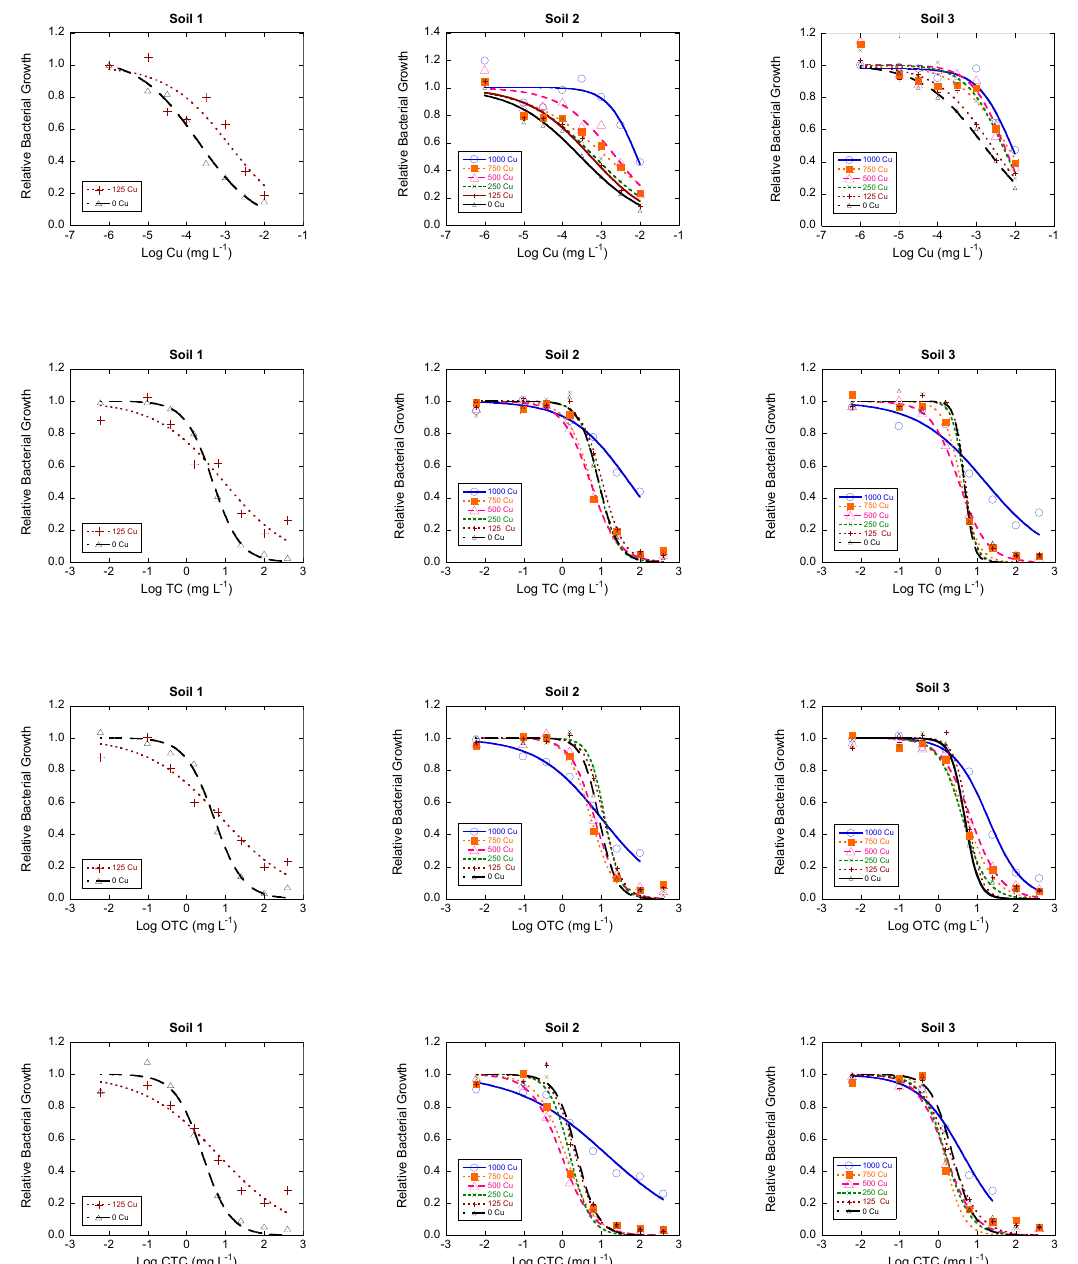
Figure 1. Dose-response curves showing the inhibition of bacterial community growth in response to increases of Cu or antibiotics (TC, OTC and CTC) concentrations in the bacterial suspensions, expresses as log concentration (mg L − 1 ). Each line represents one of the six microcosms tested in the soil (0, 125, 250, 500, 750 and 1000 mg Cu kg − 1 of soil). Dose-response curves were modeled using a logistic model. A curve shifted to the right indicates increases in bacterial community tolerance to Cu or antibiotics (TC, OTC or CTC). TC: tetracycline; OTC: oxytetracycline; CTC: chlortetracycline.